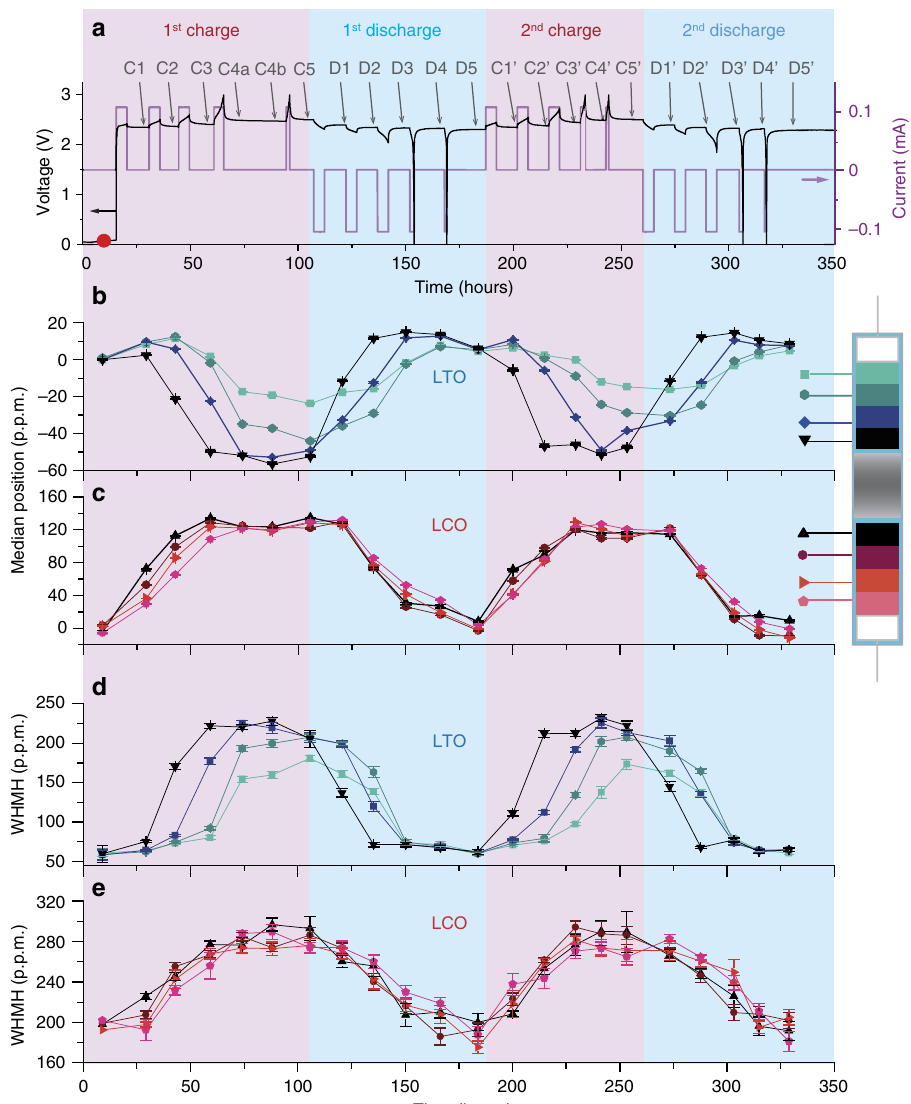
Figure 5 | Evolution of the localized in situ spectra. ( a ) Voltage and current as a function of time. ( b , c ) Evolution of the median position for four 100 m m- thick slices inside the LTO and LCO electrodes. The slices are colour-coded using increasing brightness with the distance from the separator. ( d , e ) Evolution of the full width at half-median height (WHMH) for each slice. Error bars indicate the uncertainty from the fit as described in Battery assembly . The active material (Li 4 Ti 5 O 12 or LiCoO 2 ) was mixed with polyvinylidene fluoride (Kynar Flex 2801 from Arkema) and carbon super P (Timcal) (80:10:10 w/w/w) in acetone in an agate mortar. Dense electrode pellets (5mm-diameter) were pressed with a uniaxial press at 2 tons and dried at 120 (cid:2) C for 24h under vacuum before assembly in the glove box. SEM micrographs are shown in Supplementary Fig. 1. The battery was assembled in a Jacomex argon-filled glove box, using the electrochemical cell that we developed previously for in situ NMR measurements 25 . The 444 m m-thick positive electrode had a theoretical surface capacity of 13.46mAhcm (cid:2) 2 considering 0.5 Li per Co (24.1mg). The 495 m m-thick negative electrode had a theoretical surface capacity of 14.48mAhcm (cid:2) 2 considering 3 Li per Ti (20.3mg). The two electrodes were separated by two pieces of porous glass microfiber (Whatman, type GF/D). The whole content of the battery was soaked in LP30 electrolyte (1moll (cid:2) 1 LiPF 6 in ethylene carbonate and dimethyl carbonate in weight ratio 1:1, Merck). The current collectors were made of aluminium and copper.